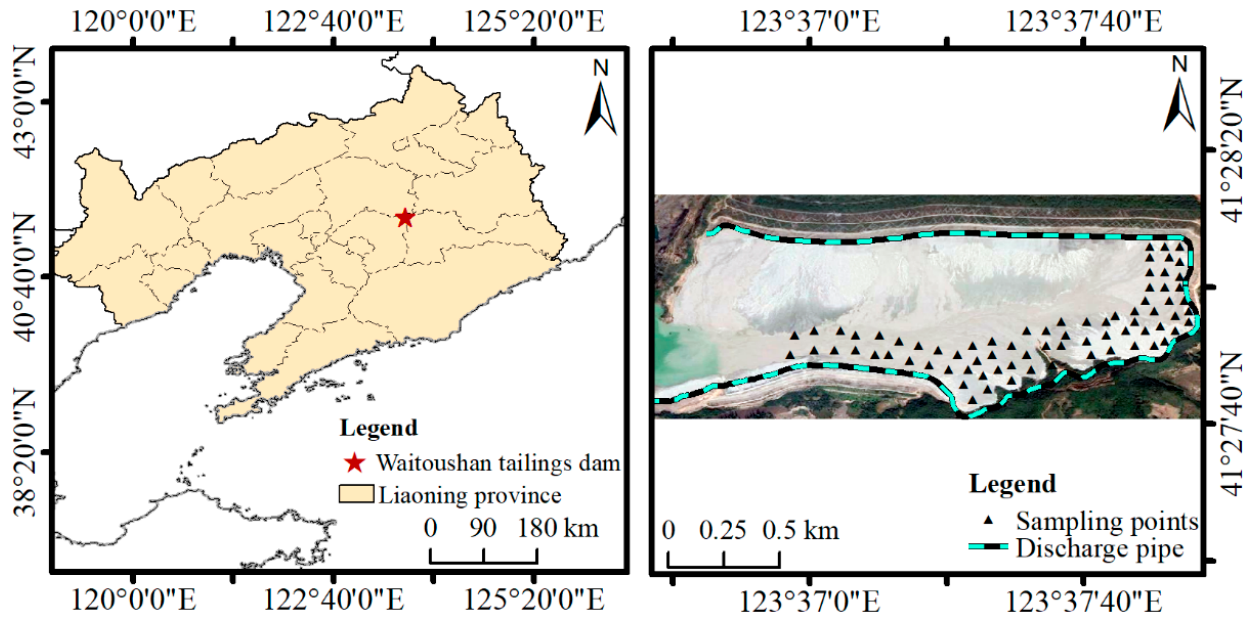
Figure 1. The geographical location of the study area. Field surveys were conducted in July 2020. To make the collected samples representa- tive, sampling points were randomly placed along the eastern and southern outlets. A total ring knife of dimensions 79.8 mm × 20 mm on the surface of the tailing dam. The samples were oven-dried, ground, and sieved into a maximum size of 0.075 mm.